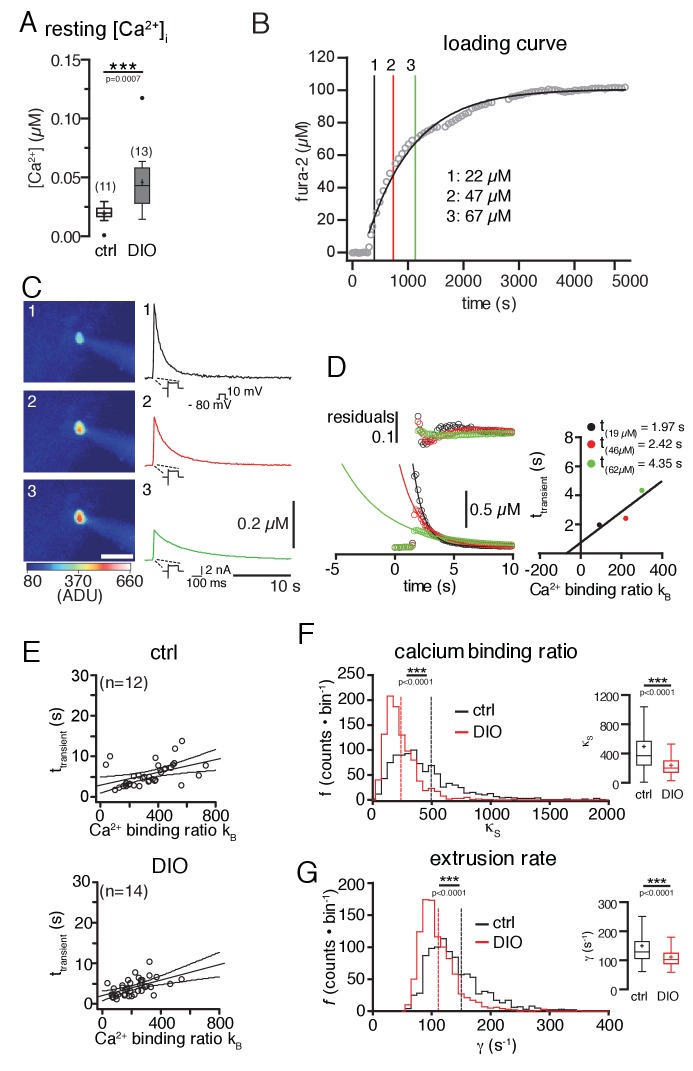
Diet-induced obesity changes the endogenous Ca2+-handling properties of POMC neurons.Ca2+ handling was analyzed using a combination of patch-clamp recordings, ratiometric Ca2+ imaging, and the ‘added buffer approach’. (A) Ca2+ resting level. The concentration of free cytosolic Ca2+ was increased in DIO mice. (B–G) Ca2+-handling properties. (B) fura-2 loading curve. POMC neurons were loaded via the patch pipette with the ratiometric Ca2+ indicator fura-2, which also serves as the added Ca2+ buffer. Fura-2 fluorescence was acquired at 360 nm excitation (isosbestic point of fura-2) every 30 s, and converted into fura-2 concentrations. (C) Decay kinetics of voltage-induced Ca2+ transients of the POMC neuron in (B). The images (left panels) were acquired at times indicated in (B) and demonstrate the increasing fura-2 concentration during loading. The graphs (right panels) demonstrate the effect of increasing added Ca2+ buffer (fura-2) concentrations on the decay kinetics of voltage-evoked Ca2+ transients. (C and D) Analysis of endogenous Ca2+-handling parameters in a single cell. With increasing fura-2 concentrations, the amplitudes of transients decreased, and the time constants (τtransient) for decay were prolonged (C and D). The decay time constants were plotted against the Ca2+-binding ratios of fura-2 (κB) (D). κB was calculated from the intracellular fura-2 concentration, the Kd of fura-2, and the resting concentration of free intracellular Ca2+. The solid line represents the linear fit to the data. An estimate of κS was obtained as the negative x-axis intercept. The Ca2+ extrusion rate is estimated from the slope of the fit and the endogenous decay time constant from the intercept with the y-axis. (E) The decay time constants of all recorded neurons were plotted as a function of κB for all POMC neurons of the control and DIO mice. The best linear fits with 95% confidence bands are shown. (F and G) To estimate the variance of the endogenous Ca2+-binding ratio (κS) and the extrusion rate (γ), we used a bootstrap method (1000 samples), which provided bootstrap distributions (n = 1000) of the parameters for the control and DIO mice. Vertical lines indicate the means. (F) Distributions of κS. Sixteen counts for the control and one count for the DIO cohort between 2000 and 7500 are not shown. (G) Distribution of γ. Eighteen counts for the control and one count for the DIO cohort between 400 and 1350 are not shown. Subsequently, the distributions were log-transformed to bring them closer to a Gaussian, before applying unpaired t-tests. ***p<0.001.